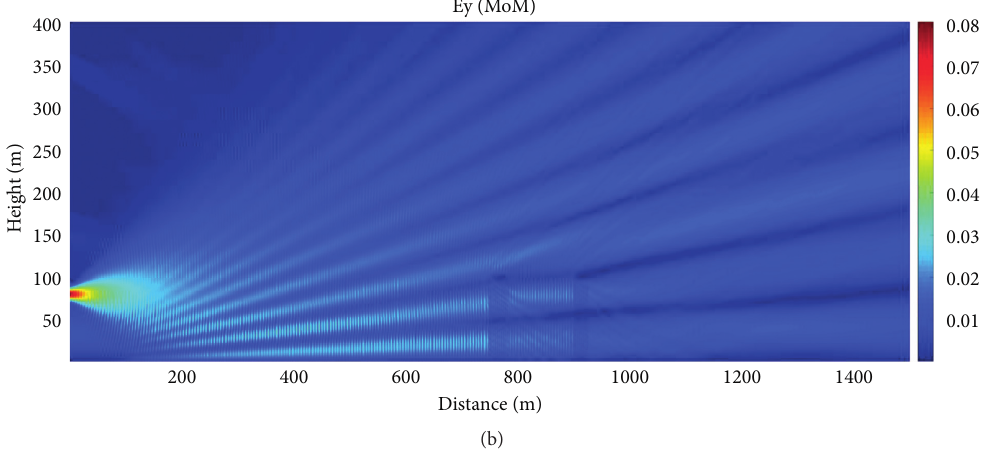
Figure 10: The field strength distribution in the entire space of H Pol. (a) new 2W-PE. (b)